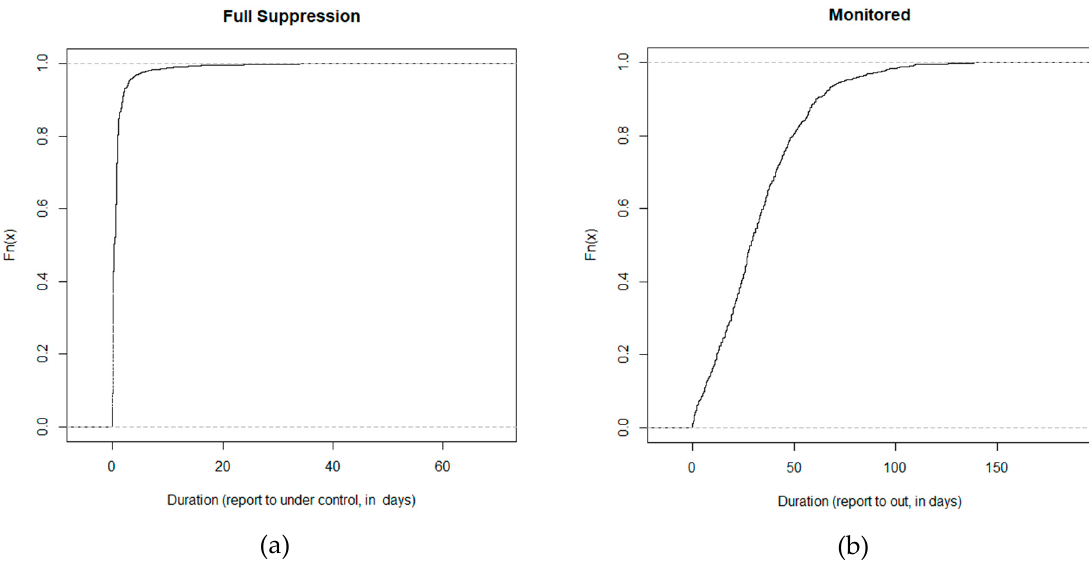
Figure 2 . Empirical cumulative distribution functions of fire duration (1990–2019) in Ontario, Canada, for: ( a ) Full suppression fires; ( b ) monitored fires. Duration is the time in days between reporting and being called “under control” for full suppression fires, or “out” for monitored fires. After data cleaning, there were 15,737 full suppression fires and 1457 monitored fires.